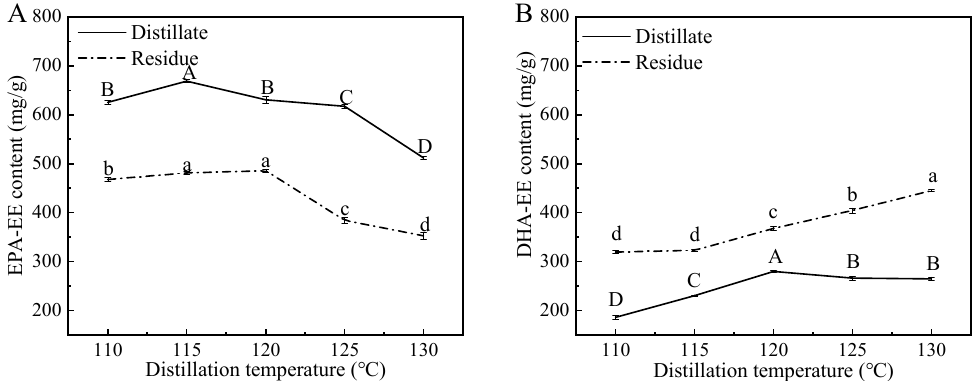
Figure 4. Effect of distillation temperature on EPA-EE content ( A ) and DHA-EE content ( B ) in distillates and residues after one-stage distillation. Values with different lowercase letters (a–d) or uppercase letters (A–D) are significantly different at p < 0.05.